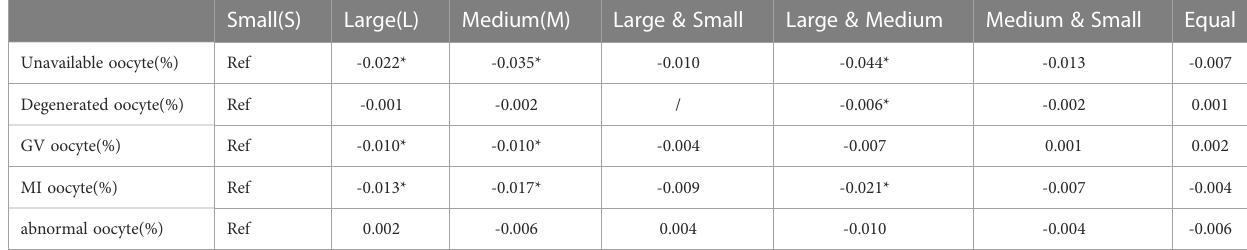
TABLE 4 GLM analysis of oocyte and embryology quality between groups in young